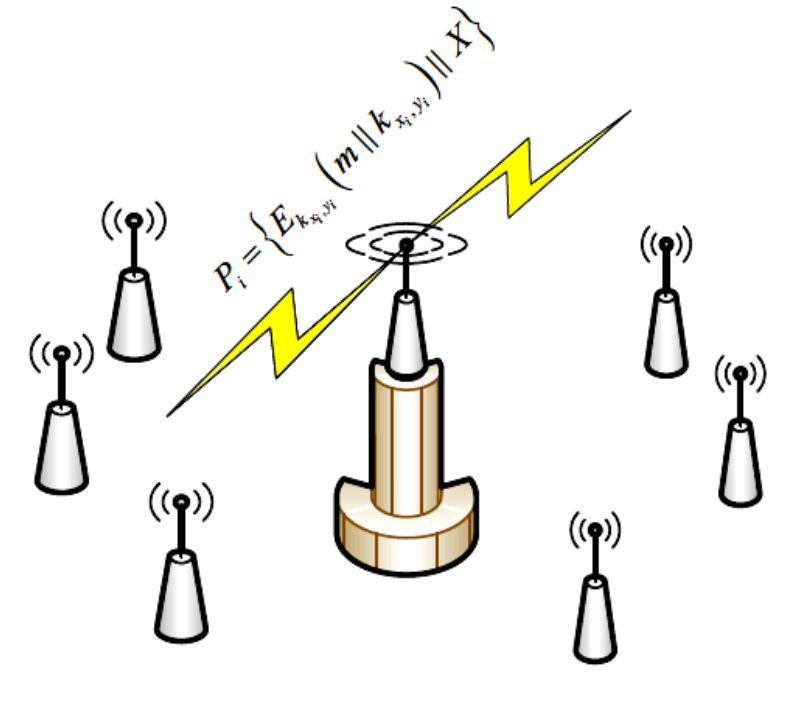
Figure 2. The Proposed Broadcasting Authentication Scheme in Wireless Sensor